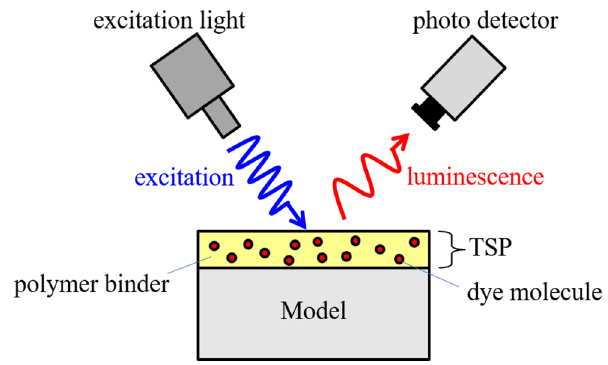
Figure 1. Principle and constitution of TSP measurement. The relationship between the luminescent intensity and temperature can be written as the Arrhenius equation in Equation (1)